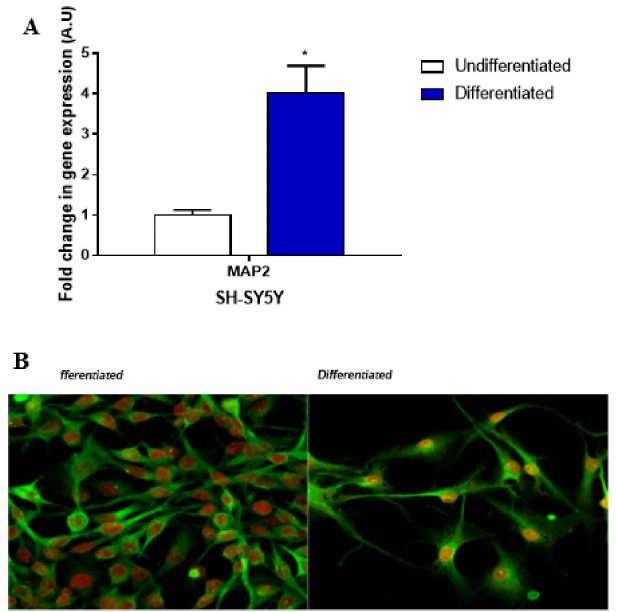
Figure 1. SH-SY5Y differentiation. ( A ) RT-qPCR analysis of MAP2 gene normalized to relative HPRT levels in both undifferentiated SH-SY5Yand RA-SH-SY5Y cells. * p < 0.05 vs. undifferentiated SH-SY5Y. ( B ) SH-SY5Y and RA-SH-SY5Y cells immunostained for β III-Tubulin antibody (neuronal marker; green) and To-Pro (nuclear marker; blue).